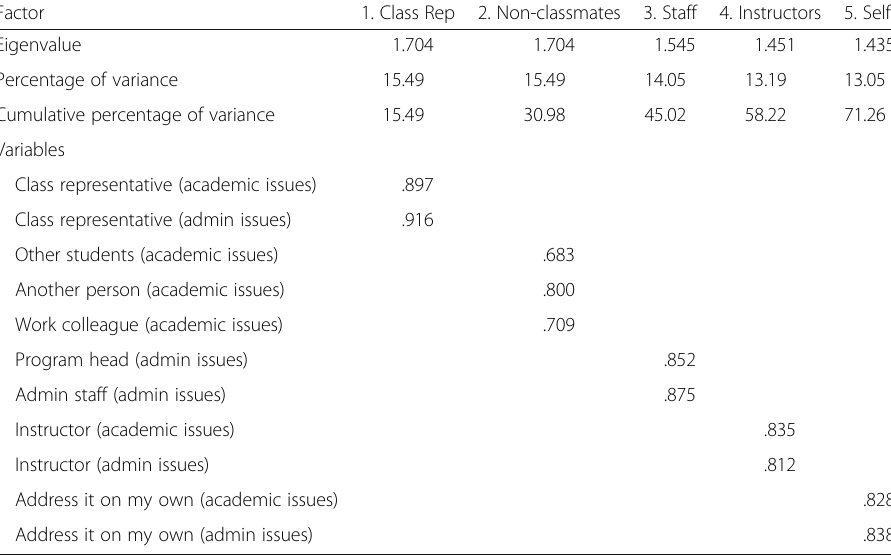
Table 3 Behavioral factor loading matrix